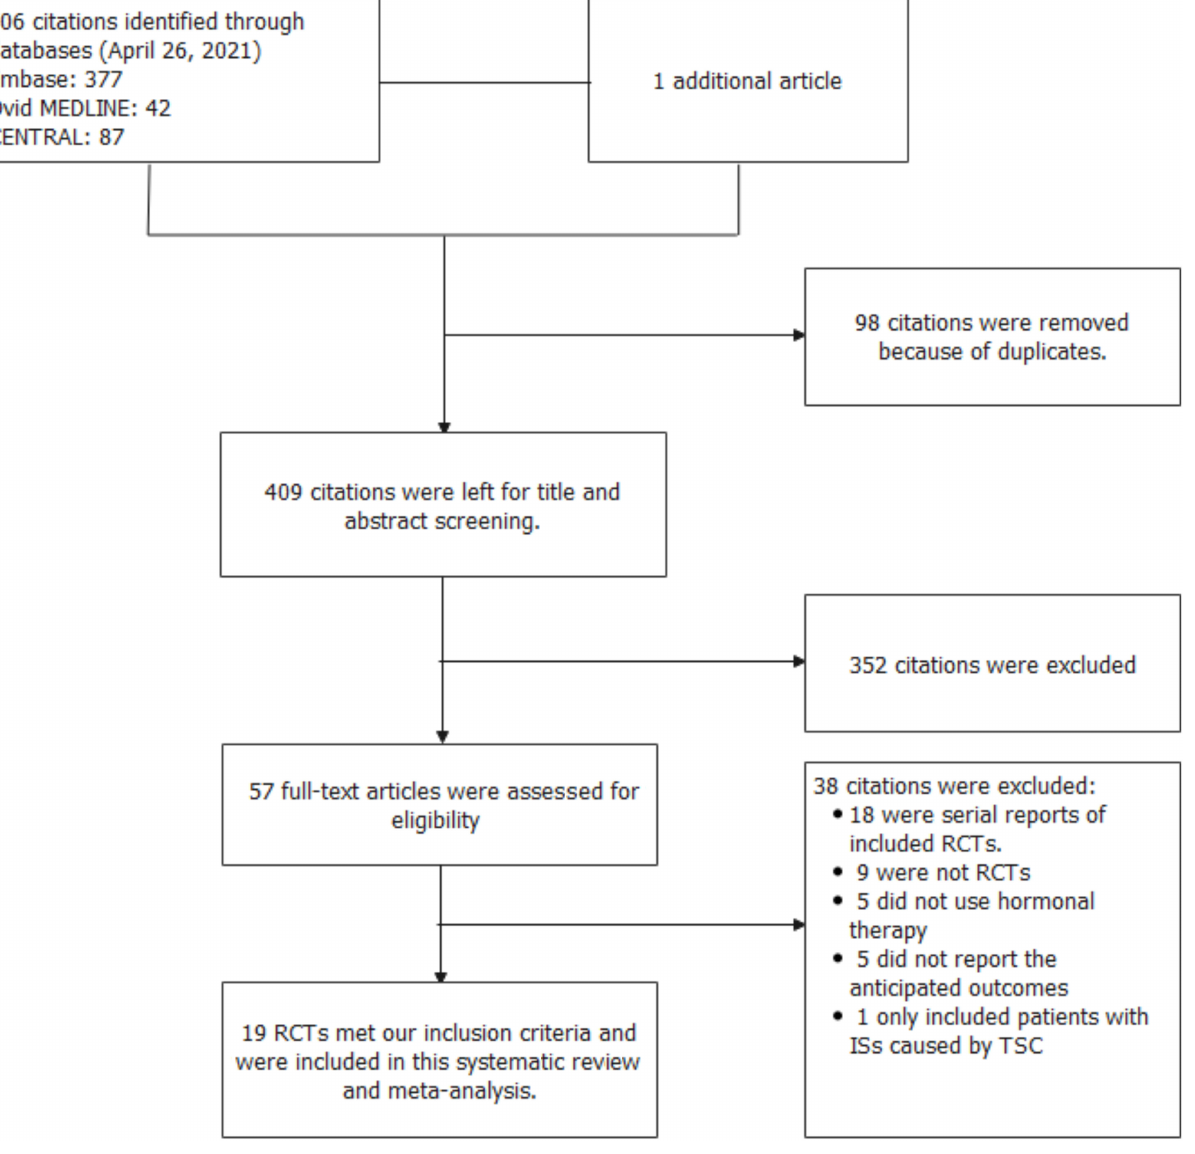
FIGURE 1 | Flow diagram of the study selection